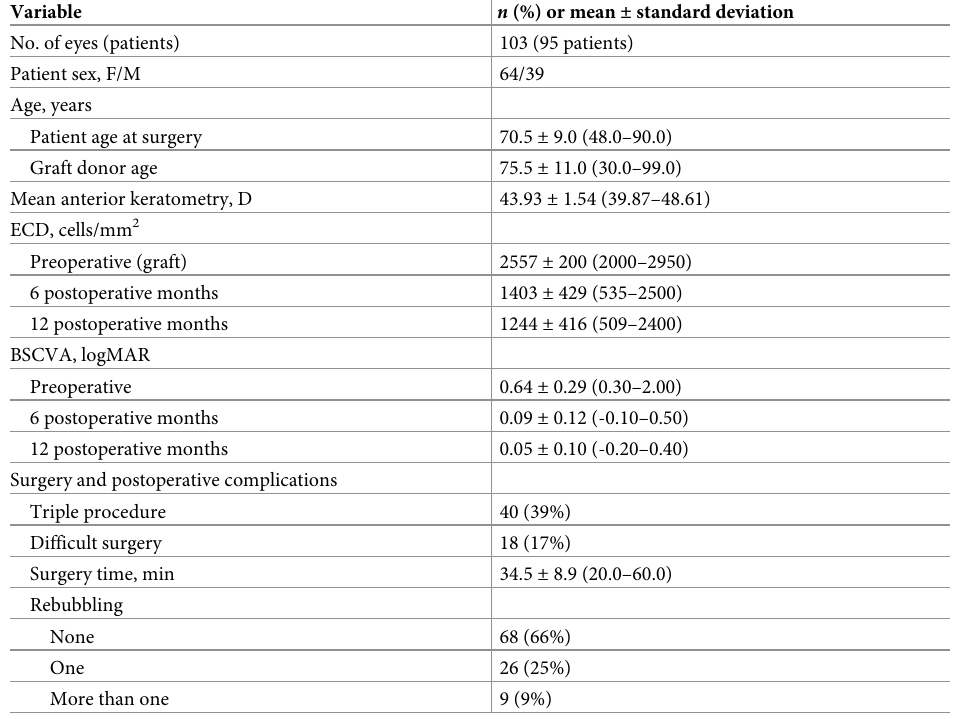
Table 1. Demographic and clinical characteristics of the patients and eyes undergoing Descemet membrane endo- thelial